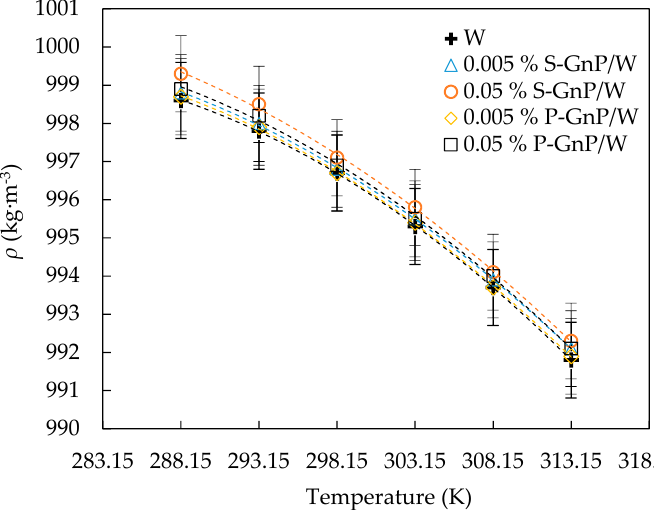
Figure 4. Densities at various temperatures for the different loaded S-GnP and P-GnP nanofluids.